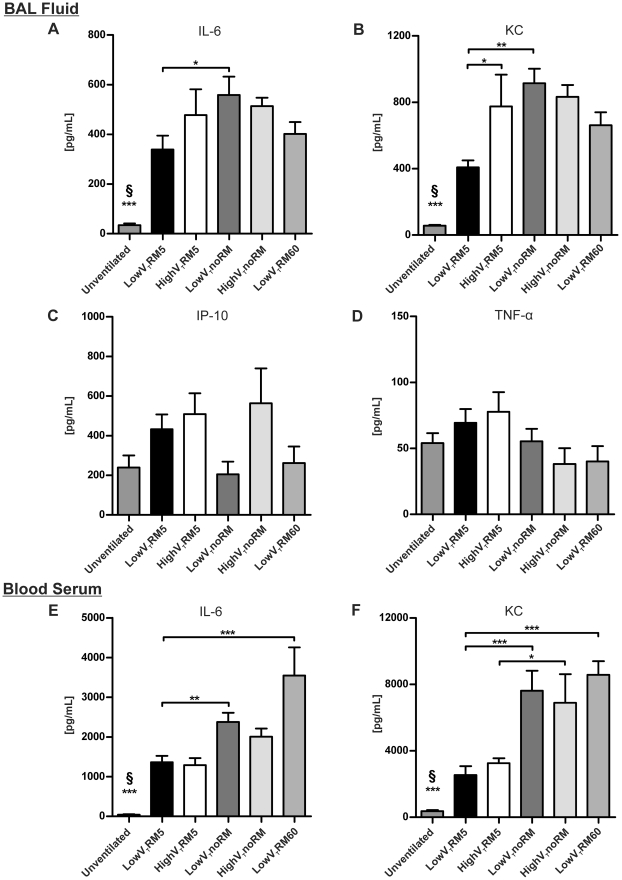
Cytokine levels.Cytokines were quantified in blood serum or BAL supernatant with commercial ELISA kits after six hours of ventilation and in unventilated mice. (Unventilated: n = 5, lowVTRM5 n = 6, highVTRM5 n = 6, lowVTnoRM n = 4 in BAL and n = 5 in serum, highVTnoRM n = 4, lowVTRM60 n = 5). * p<0.05, ** p<0.01, *** p<0.001, § *** p<0.001 versus all other groups).